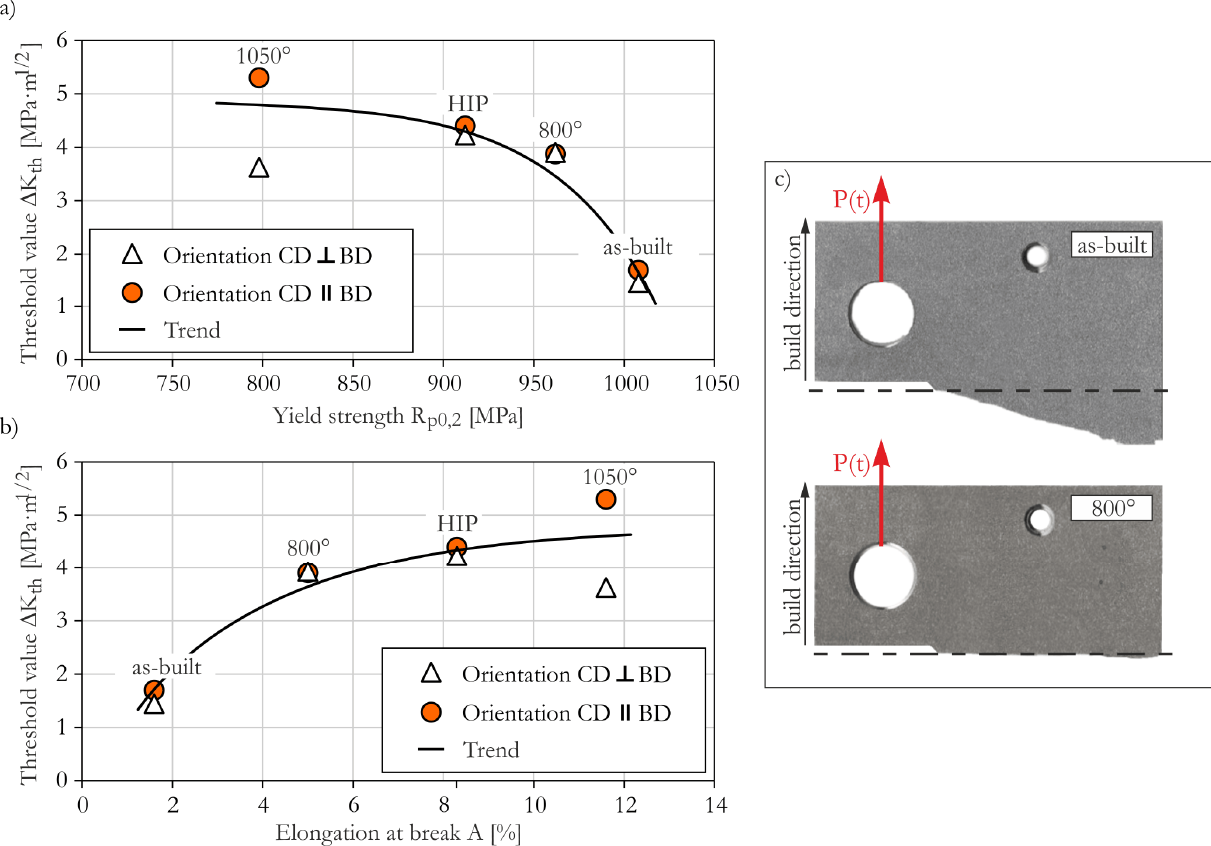
Figure 4: The dependence of threshold values on the Yield strength a) and Elongation at break b). The effect of the residual stresses on the crack path is shown in